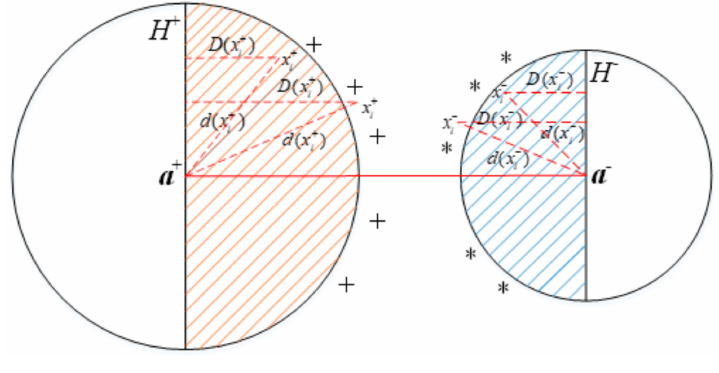
Figure 5. The case of separation.